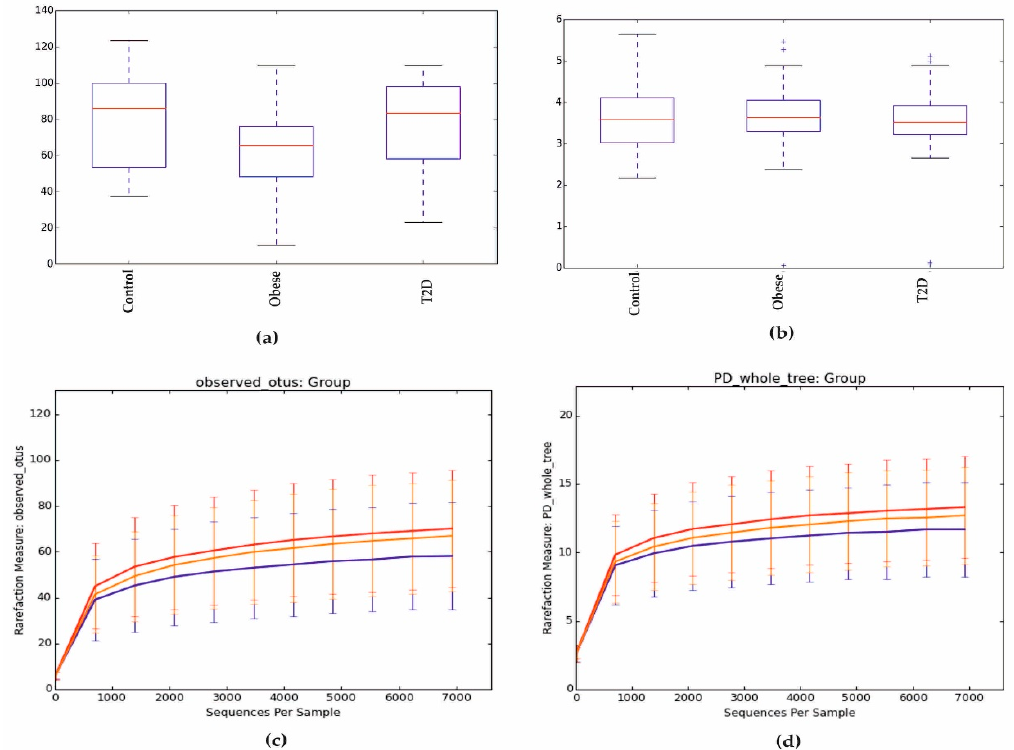
Figure 1. Alpha diversity expressed in: ( a ) Chao1, ( b ) Shannon index, ( c ) observed OUTs, ( d ) PD whole tree. PD: phylogenetic diversity.